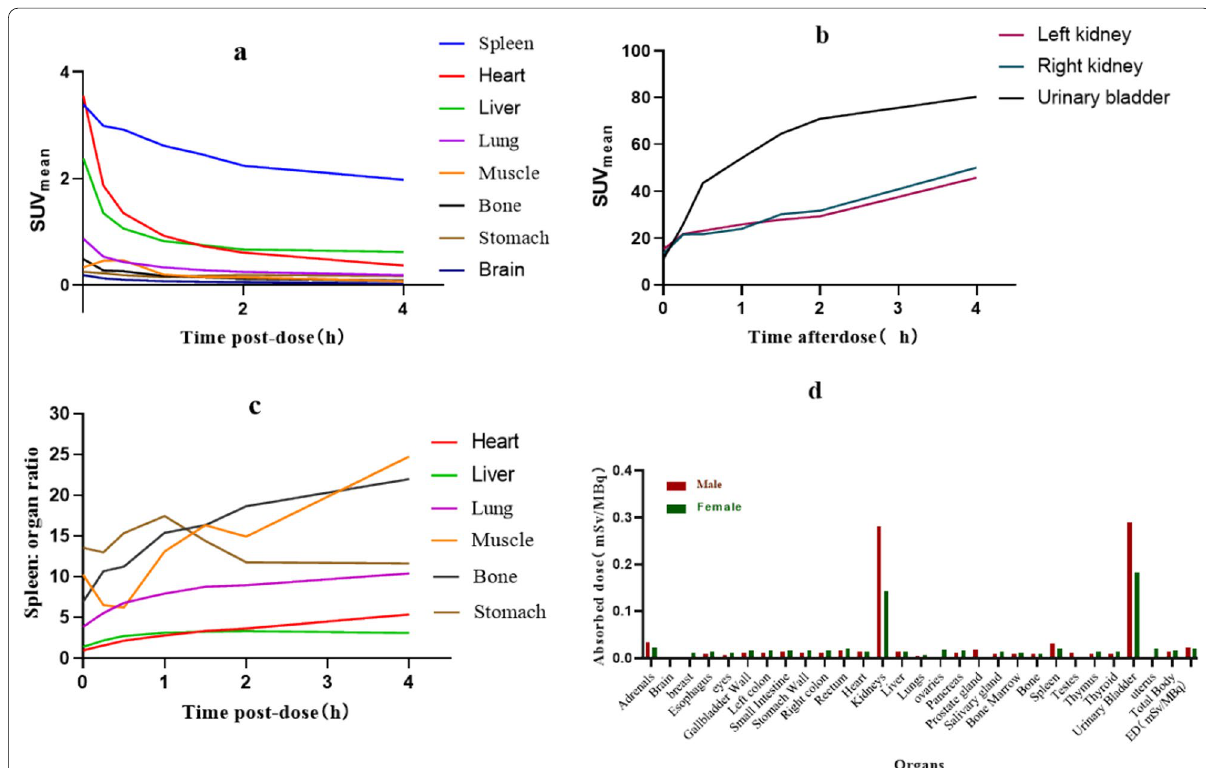
Fig. 5 Radioactivity in the ROI in images of the male cynomolgus monkeys was quantified as SUV mean. a Time-activity curves of the spleen, heart, liver, lungs, muscles, bones, stomach, and brain. b Time-activity curves of the kidneys and urinary bladder. c Spleen-to-organ (heart, liver, lungs, muscles, bones, and stomach) ratio curves at different time intervals. d Effective dose estimation from cynomolgus monkeys to adult humans (mSv/ MBq); data of each organ shows the total effective